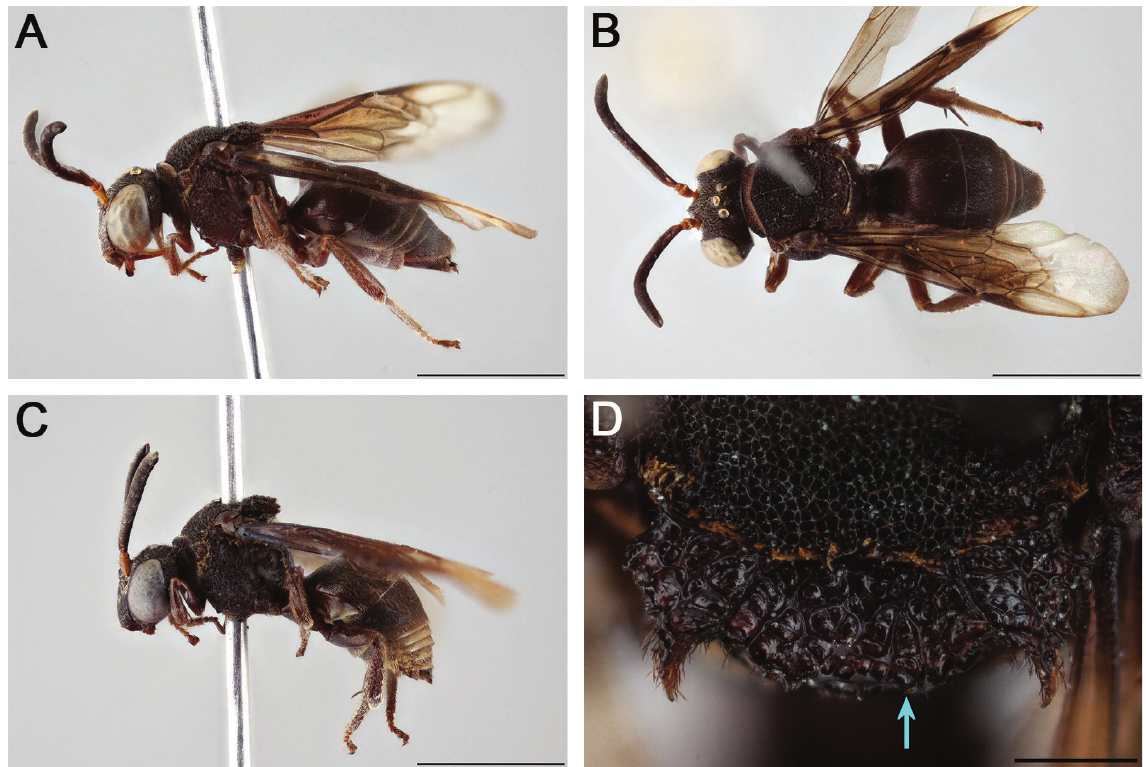
Fig. 8. Epeolus claripennis Friese, 1908. A . Female, habitus, lateral view. B . Female, habitus, dorsal view. C . Male, habitus, lateral view. D . Female axillae and mesoscutellum, dorsal view (blue arrow indicates one of two posteriorly directed tooth-like projections of mesoscutellum). Scale bars: A–C = 3 mm; D = 0.5